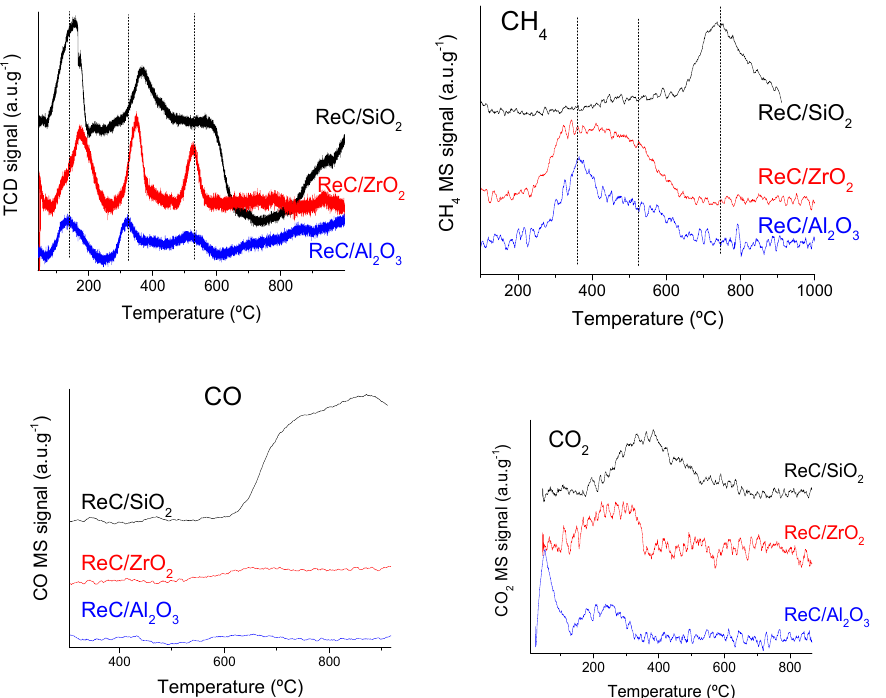
Figure 4. Evolution of the TCD signal and MS fragments of CH 4 , CO, and CO 2 formed during TPR. The CH 4 traces give additional insights into the species present on the catalysts. In the case of ReC supported over Al 2 O 3 and ZrO 2 , the last feature at around 500 ◦ C is ac- companied by CH 4 formation. According to the literature, CH 4 results from gasification reaction and can be associated with different carbon species depending on the temper- ature [28,38,39]. For this reason, the CH 4 traces were deconvoluted and the results are presented in Figure 5. For the ReC/Al 2 O 3 and ReC/ZrO 2 catalysts, three components could be distinguished: 376, 475, and 552 ◦ C for ReC/Al 2 O 3 ; 327, 412, and 520 ◦ C ReC/ZrO 2 . The first two peaks correspond to carbidic species, whereas the latter is related to pyrolitic car- bon [28,38,39]. Thus, two different carbidic phases were detected on the catalysts, although the lower temperatures obtained for ReC/ZrO 2 suggest that the particles interacted less strongly with the ZrO 2 support than with the Al 2 O 3 support.